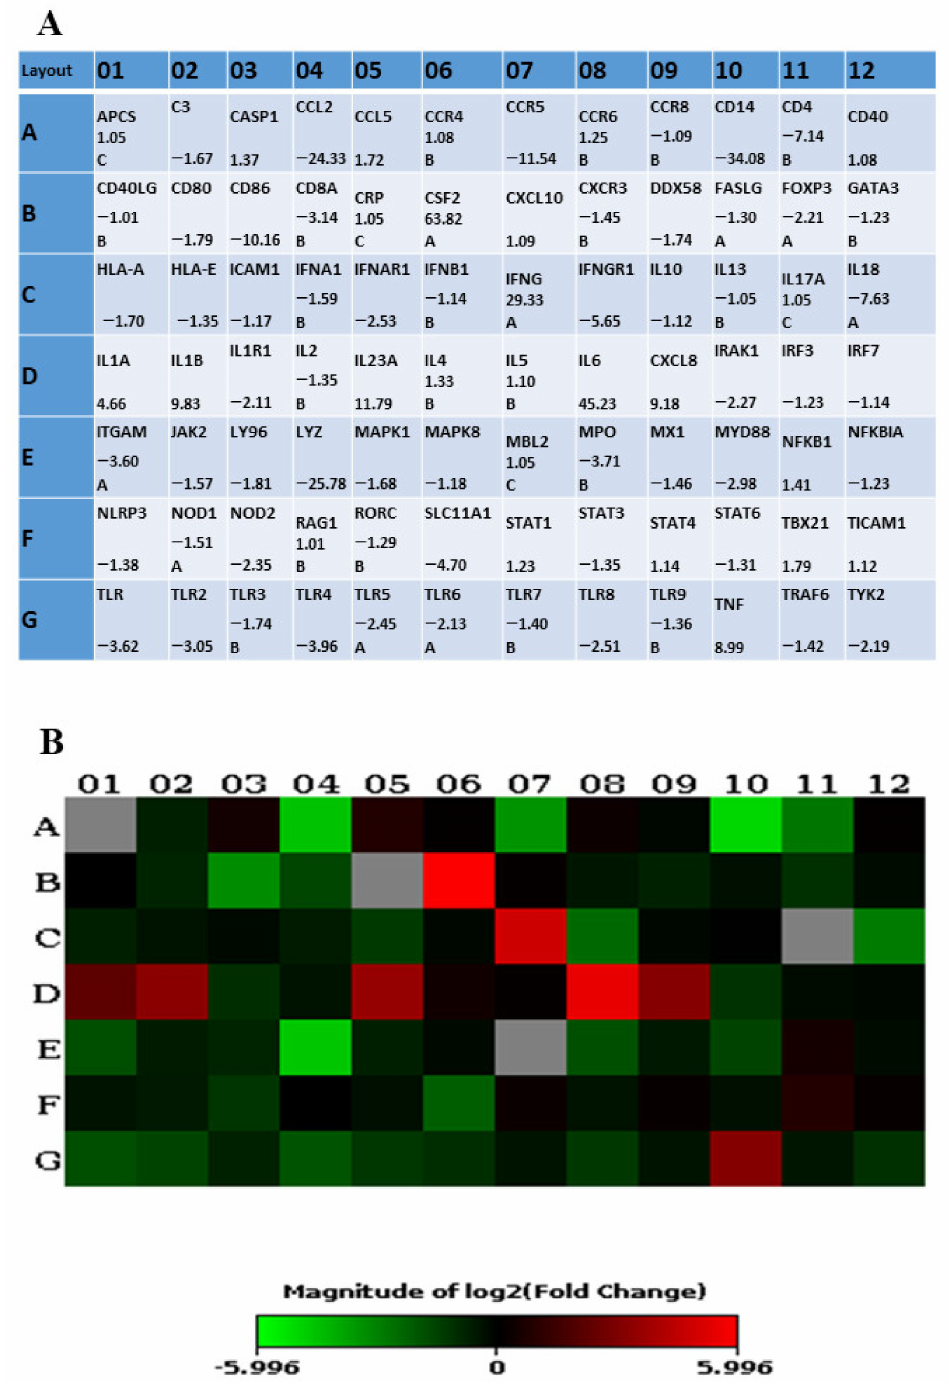
Figure 1. Effects of co-culturing ST285 with monocytes ( n = 3) on gene/RNA expression compared to control monocytes after 24 h. ( A ) All of the 84 genes are shown including those with significant high up/down regulated genes (more than 2-fold) and those with no significant changes (less than 2-fold). The housekeeping genes (HKG) panel and other genes used for normalization of the raw data are not presented. HKG includes Hs.520640, Hs.534255, Hs.592355, Hs.412707, and Hs.546285, with respective symbols as ACTB, B2M, GAPDH, HPRT1, and RPLP0. In the case of no letter or comments, the expression of gene/s is relatively high in both the test and control group (threshold cycle (CT) is <30). Letter A specifies the gene’s average threshold cycle to be reasonably high (>30) in the treated samples or controls and relatively low (<30) in the other/opposite samples. Therefore, in the case of presenting fold-changes with letter A, the estimated fold-change may be an underestimate. Letter B suggests a reasonably high (>30) gene average threshold cycle, that means a low level of average